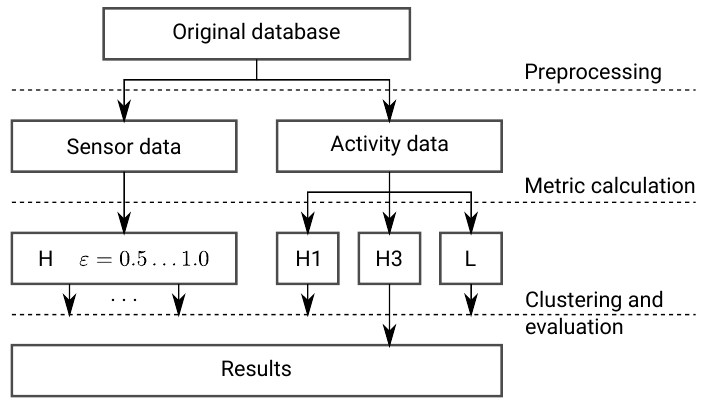
Figure 1. Flowchart of the proposed